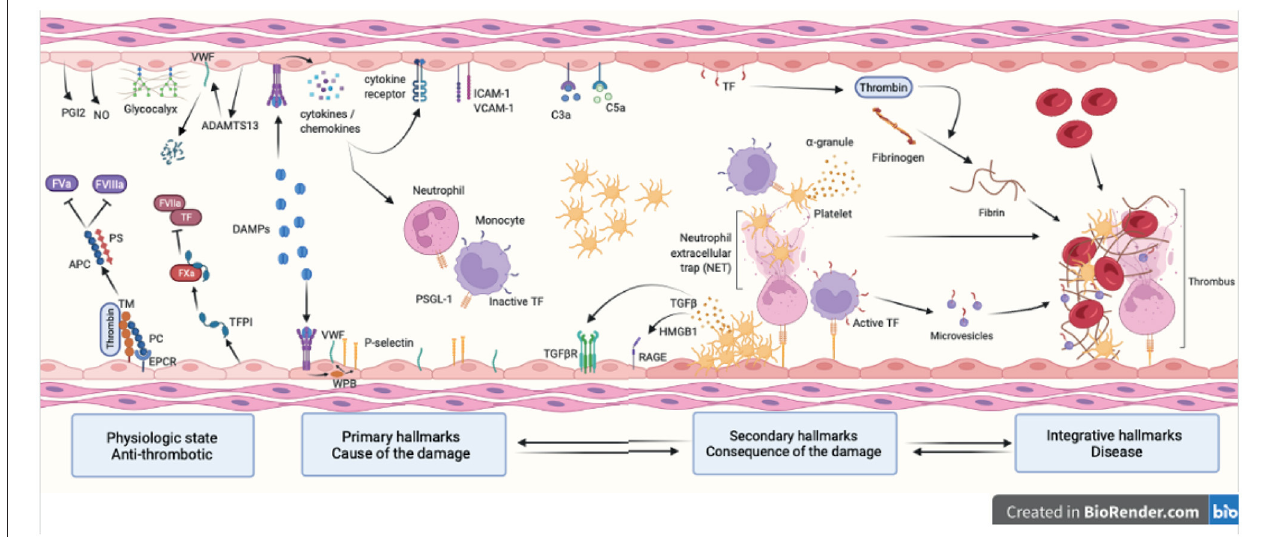
FIGURE 1 | Hallmarks of venous thromboembolism. Healthy endothelial cells provide an anti-coagulant surface by expressing anti-coagulant factors (TM, TFPI, EPCR and PC) limiting thrombin generation. Intact glycocalyx and production of NO and PGI 2 also protect against venous thrombosis. Thrombo-inflammation is triggered by the release in the bloodstream of DAMPs following cell injury. DAMPs interact with the endothelium and promote the release of cytokines, chemokines and WPB content and expression of adhesion molecules (primary hallmarks). This leads to endothelial dysfunction characterized by platelet and leukocyte recruitment that will in turns become activated and secrete pro-inflammatory and pro-coagulant molecules further contributing to thrombosis (secondary hallmarks). Together with the complement system, platelets and endothelial cells induce NET formation and TF expression in monocytes through interactions between P-selectin and PSGL-1. This initiates the coagulation cascade through both the intrinsic and extrinsic pathways and ultimately leads to thrombin-induced fibrin generation and formation of an obstructive clot (integrative hallmarks). APC, activated protein C; TM, thrombomodulin; TFPI, tissue factor pathway inhibitor; EPCR, endothelial protein C receptor; PC, protein C; NO, nitric oxide; PGI 2 , prostaglandin I 2; DAMP, damage-associated molecular pattern; WPB, Weibel Palade body; NET, neutrophil extracellular trap; TF, tissue factor; PSGL-1, P-selectin glycoprotein ligand-1; RAGE, receptor for advanced glycation endproducts; HMGB-1, high mobility group